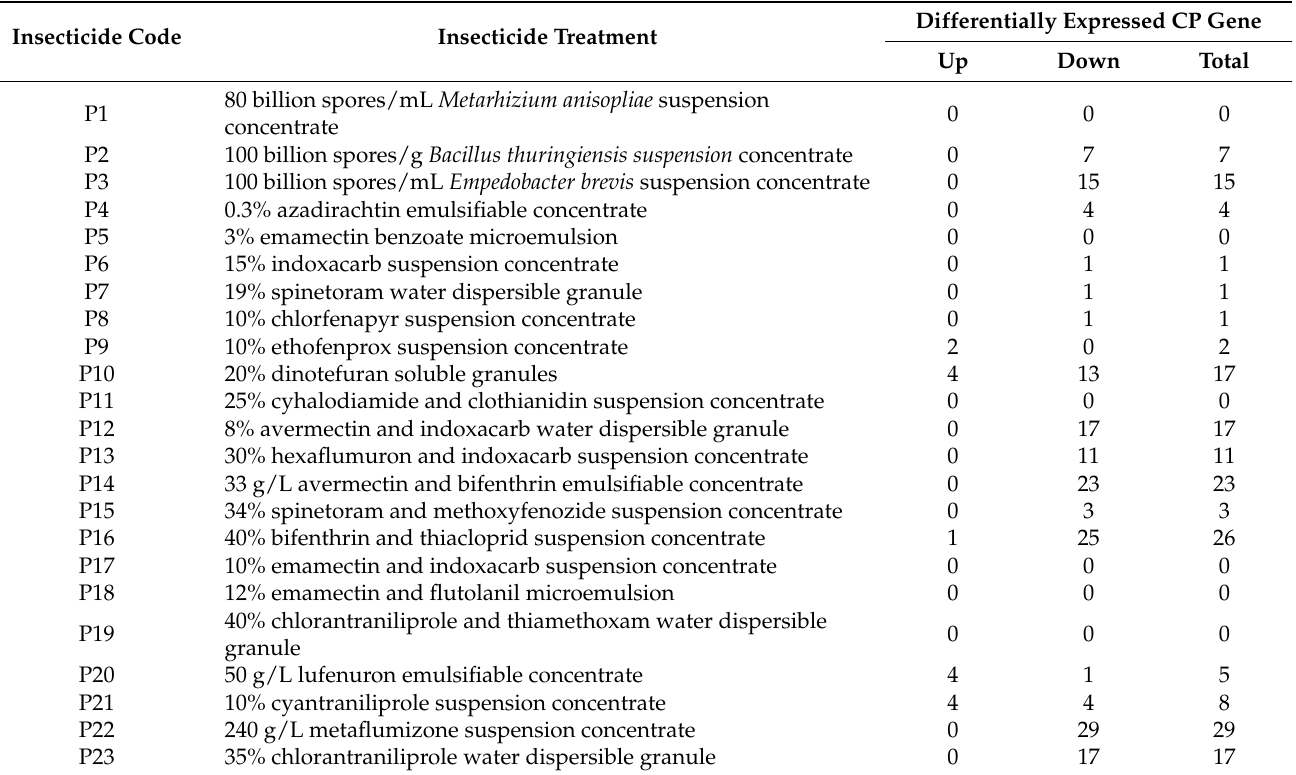
Table 2. Differentially expressed CP genes of Spodoptera frugiperda after exposure to 23 insecticides. Insecticide Code Insecticide